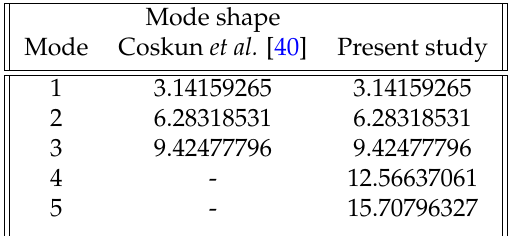
Figure 7. Dynamic response of the SWCNT for mode 4 Table 2. Comparison of present study with Coskun et al. [40] exact method for pinned - pinned condition